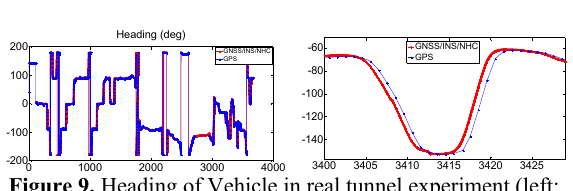
Figure 9. Heading of Vehicle in real tunnel experiment (left: GNSS and Integration heading; right: heading details)